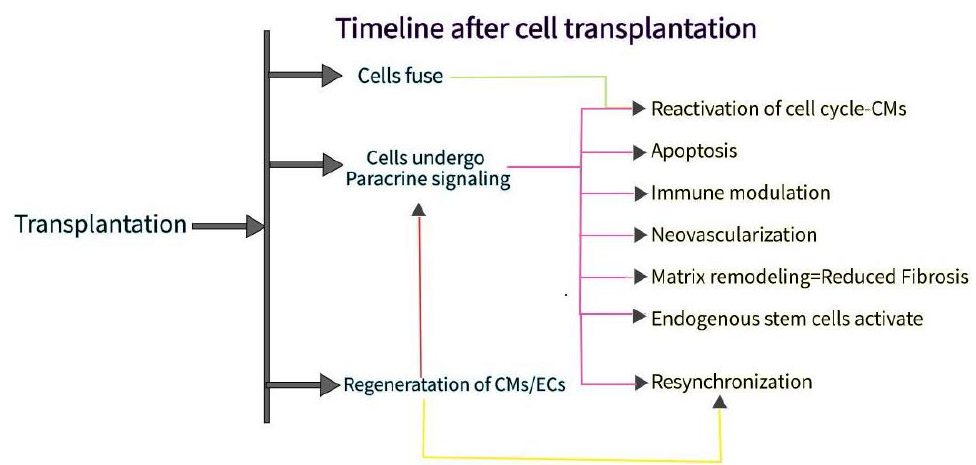
Figure 3. Transplanted cells often cause paracrine signaling, leading to apoptosis and reactivation of the cell cycle. These side effects often improve the regenerative ability of the heart.